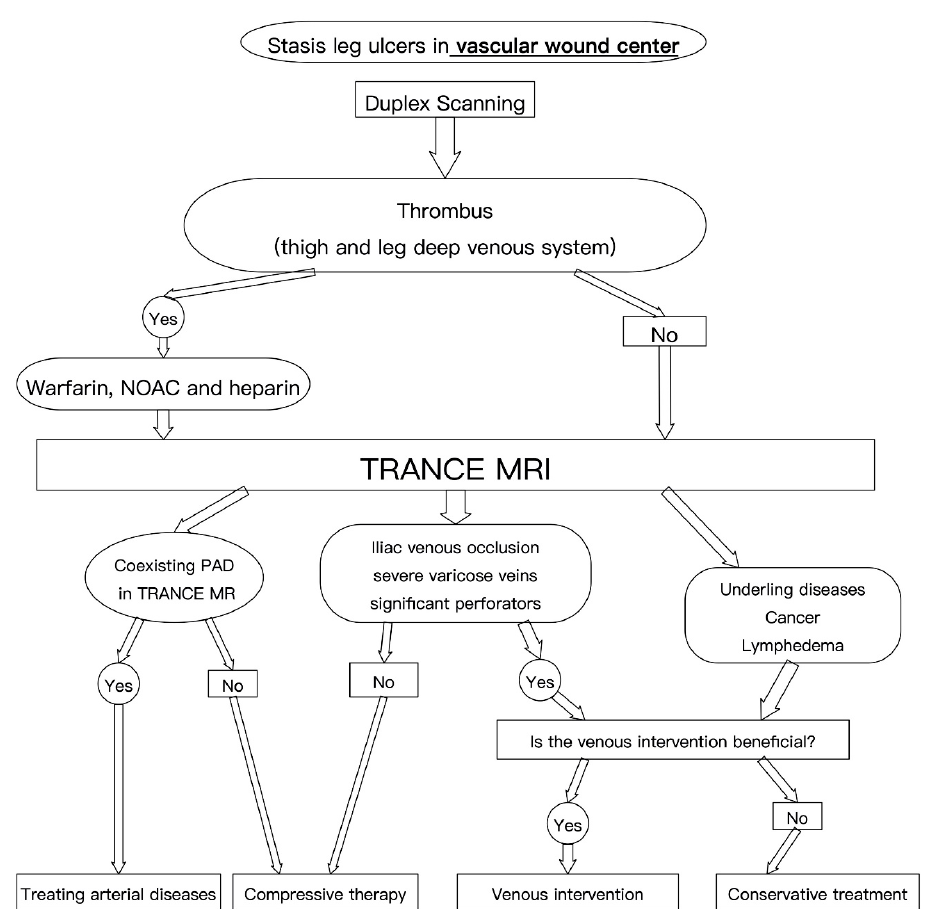
Figure 4. Therapeutic algorithm in the vascular wound center for stasis leg ulcers. NOAC: non-warfarin oral anticoagulation; PAD: peripheral arterial disease.